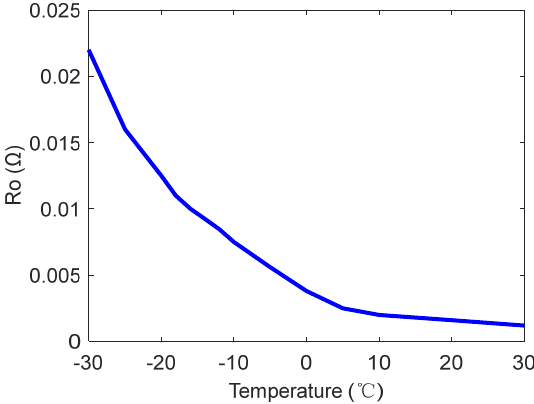
Figure 4. Ohmic resistance at di ff erent temperatures.